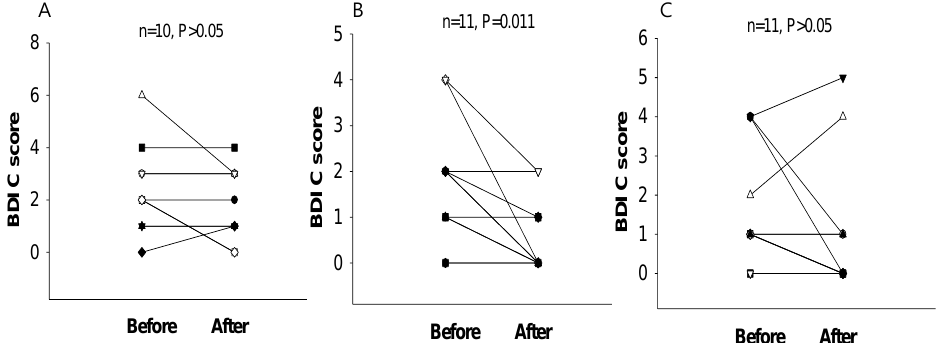
Figure 4. Differences in BDI subscale C mean scores between WNS and placebo groups. ( A ) Placebo group, ( B ) 2.4 g of WNS group, ( C ) 4.8 g of WNS. Table 3. Changes in total SRI scores and SRI subscale scores in patients after WNS treatment for two weeks.